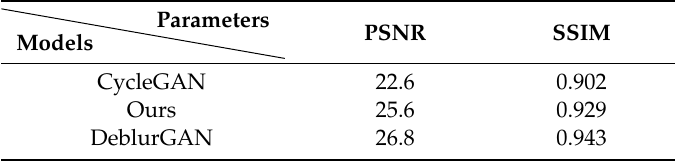
Table 1. Quantitative evaluation results on GOPRO dataset.